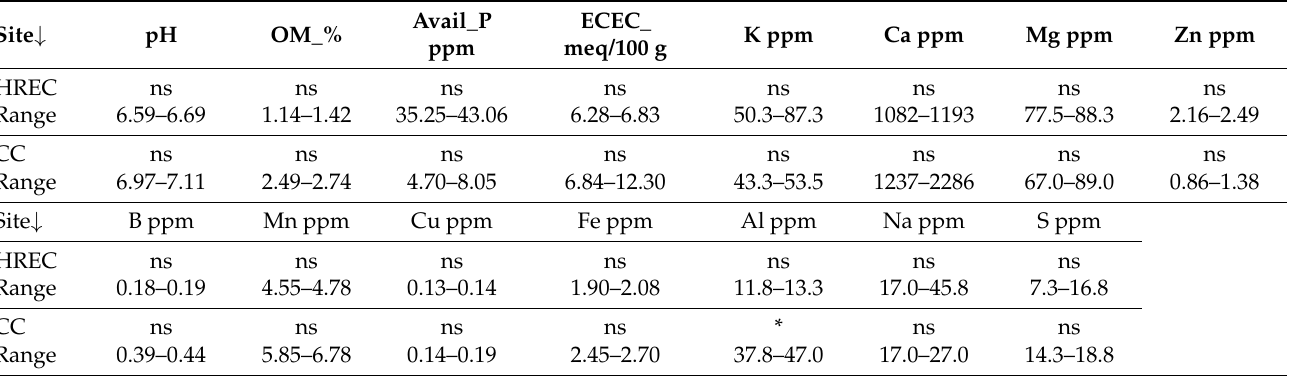
Table 3. Summary of differences in soil chemistry among fertility treatments at harvest for spinach crop at two sites.